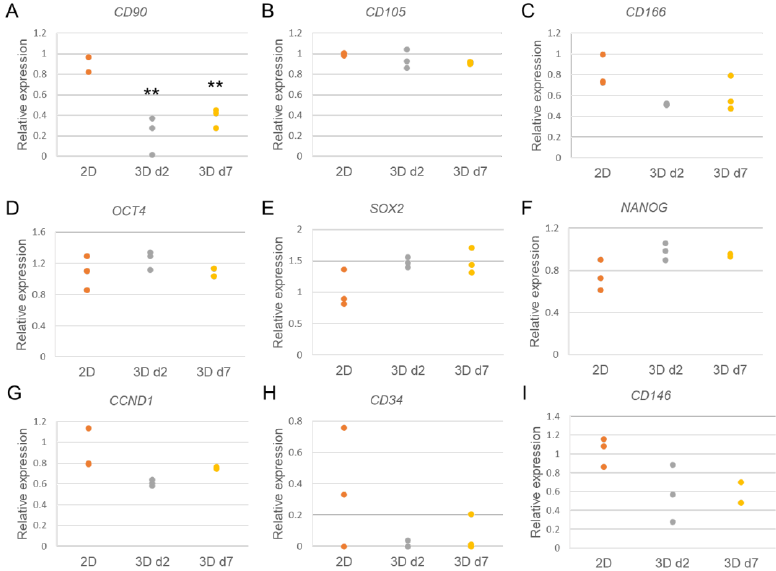
Figure 3. Quantitative real-time PCR (qRT-PCR) of specific cell markers in hASCs cultured in NFC hydrogel with 100 k cell density on d2 and d7 compared with 2D-cultured control cells. ( A – C ) Relative expression of ASC-specific cell surface markers CD90 ( A ), CD105 ( B ), and CD166 ( C ). ( D – F ) Relative expression of pluripotency markers OCT4 ( D ), SOX2 ( E ), and NANOG ( F ). ( G ) Relative expression of a cell cycle activator CCND1 . ( H , I ) Relative expression of endothelial-specific cell surface markers CD34 ( H ) and CD146 ( I ). ** p < 0.01 vs. 2D. N = 3 (3 technical replicates), except for 3D d7 samples on OCT4 , NANOG, and CD146 qRT-PCR n = 2 (3 technical replicates).